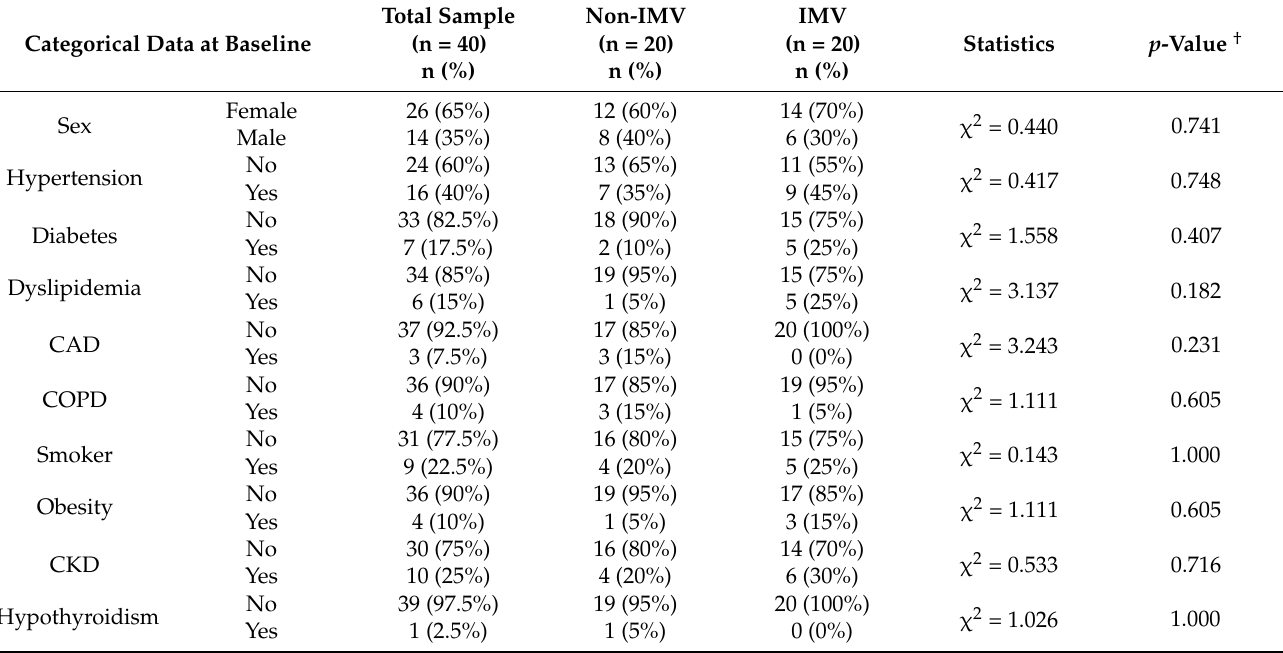
Table 2. Categorical data for COVID-19 patients with and without IMV at